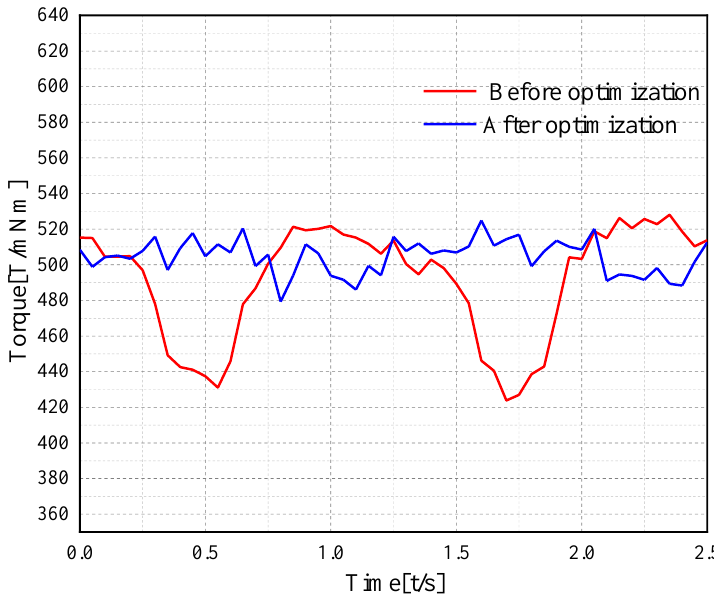
Figure 8. Output torque.